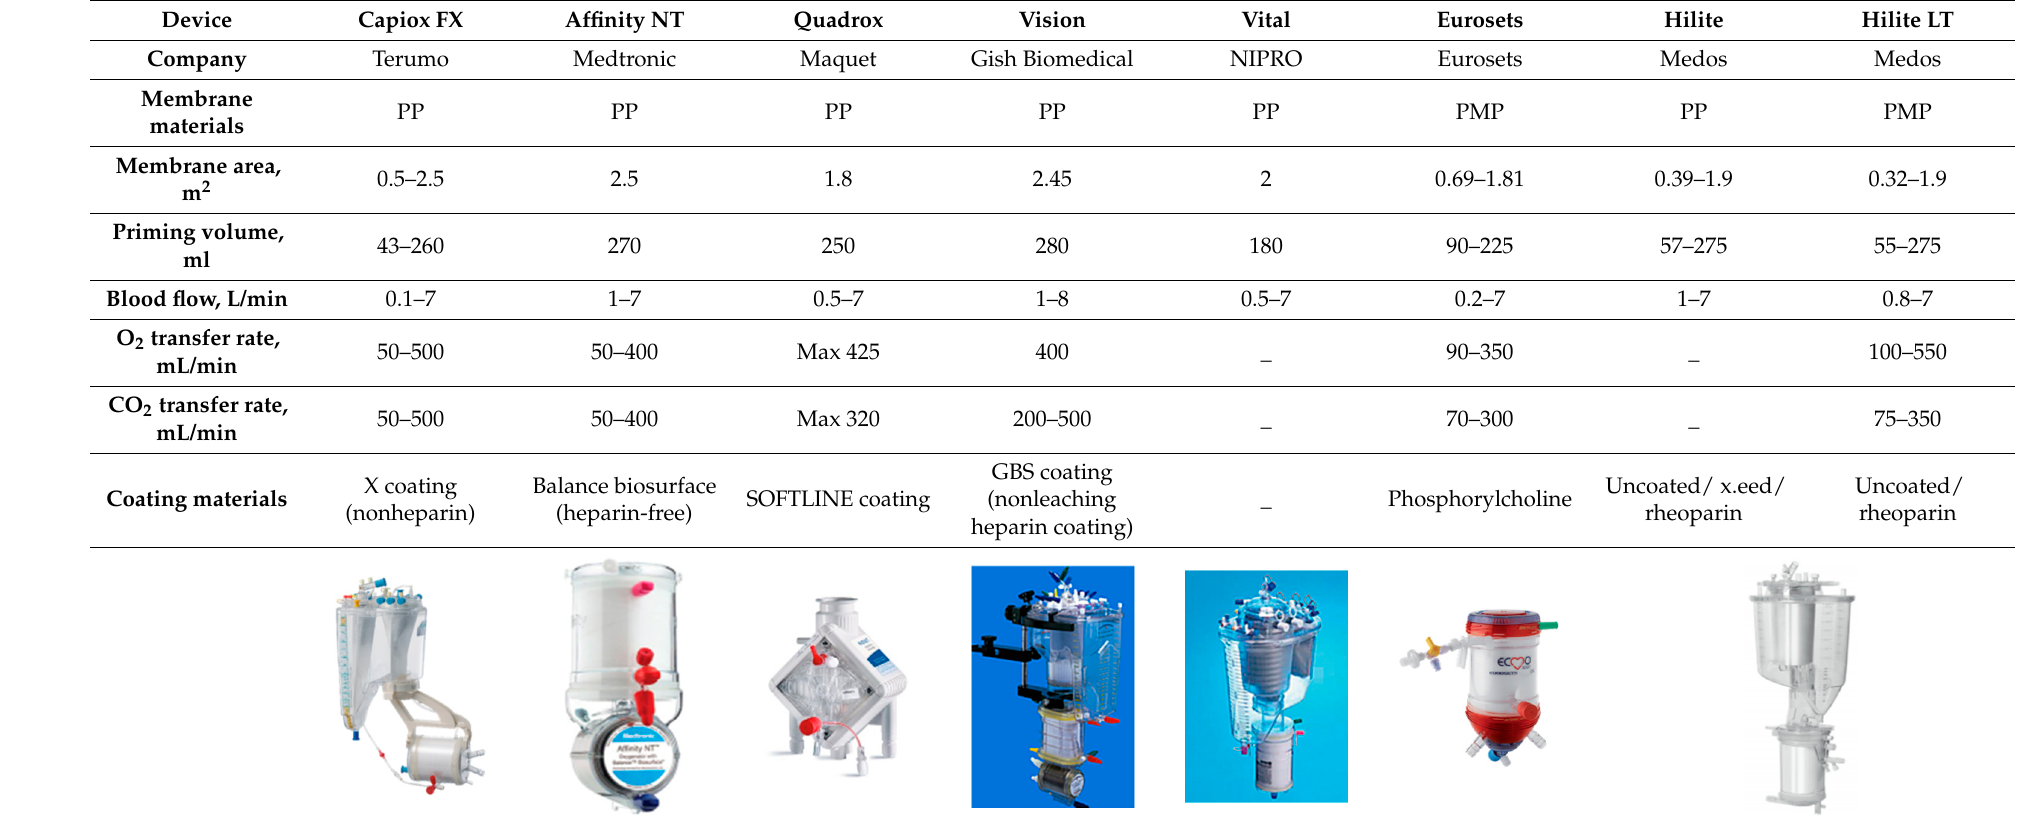
Table 5. Specifications of current commercial hollow fiber membrane blood oxygenator